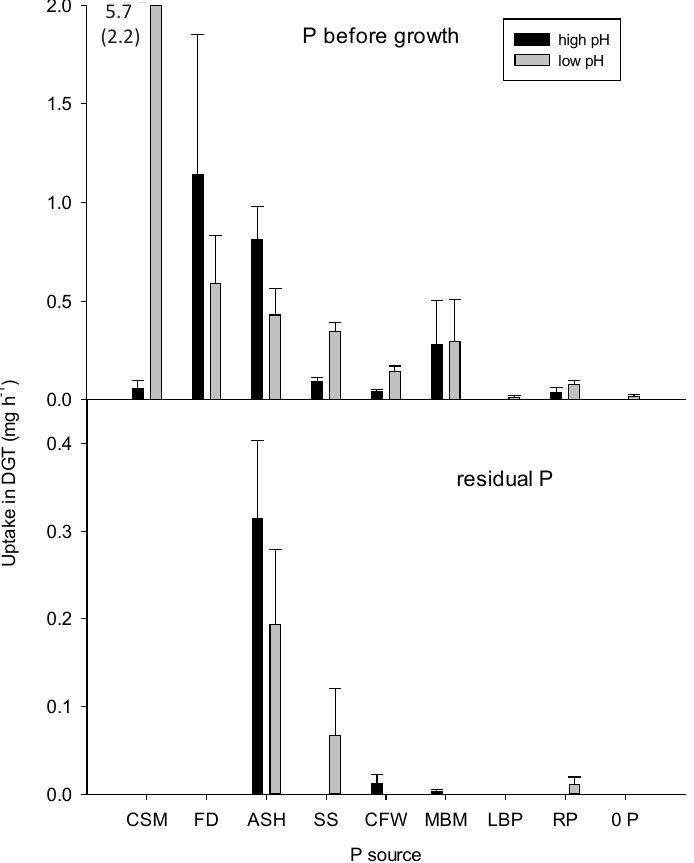
Fig. 3. Uptake of phosphorus in DGT probes per hour, before plant growth (top) and residual, after plant harvest (bottom). Error bars are standard error (n=3). The very high value in the top graph is shown as a number beside the bar (standard error in brackets).